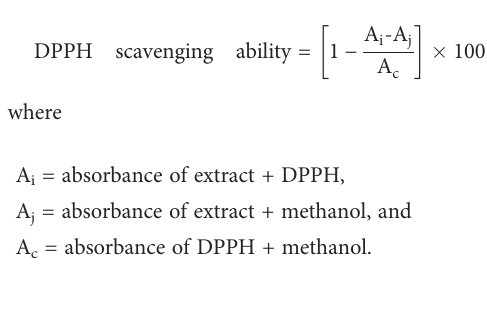
using soil substrates (Figure 4) receiving treatments with different concentrations of dry leachates of leaves and fl owers of marigold.